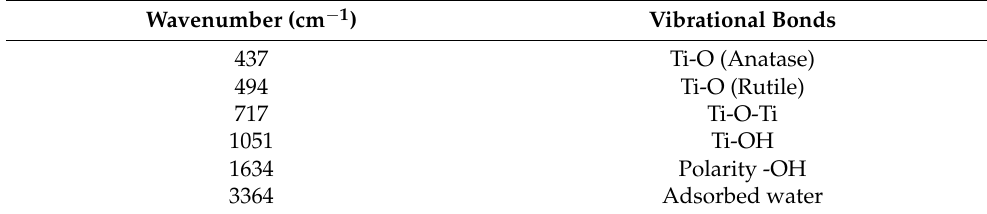
Figure 8. FTIR spectra of the TiO 2 fibers obtained after calcination at different temperatures and plasma treatments. Table 3. The corresponding vibrational bonds in the FTIR spectra.